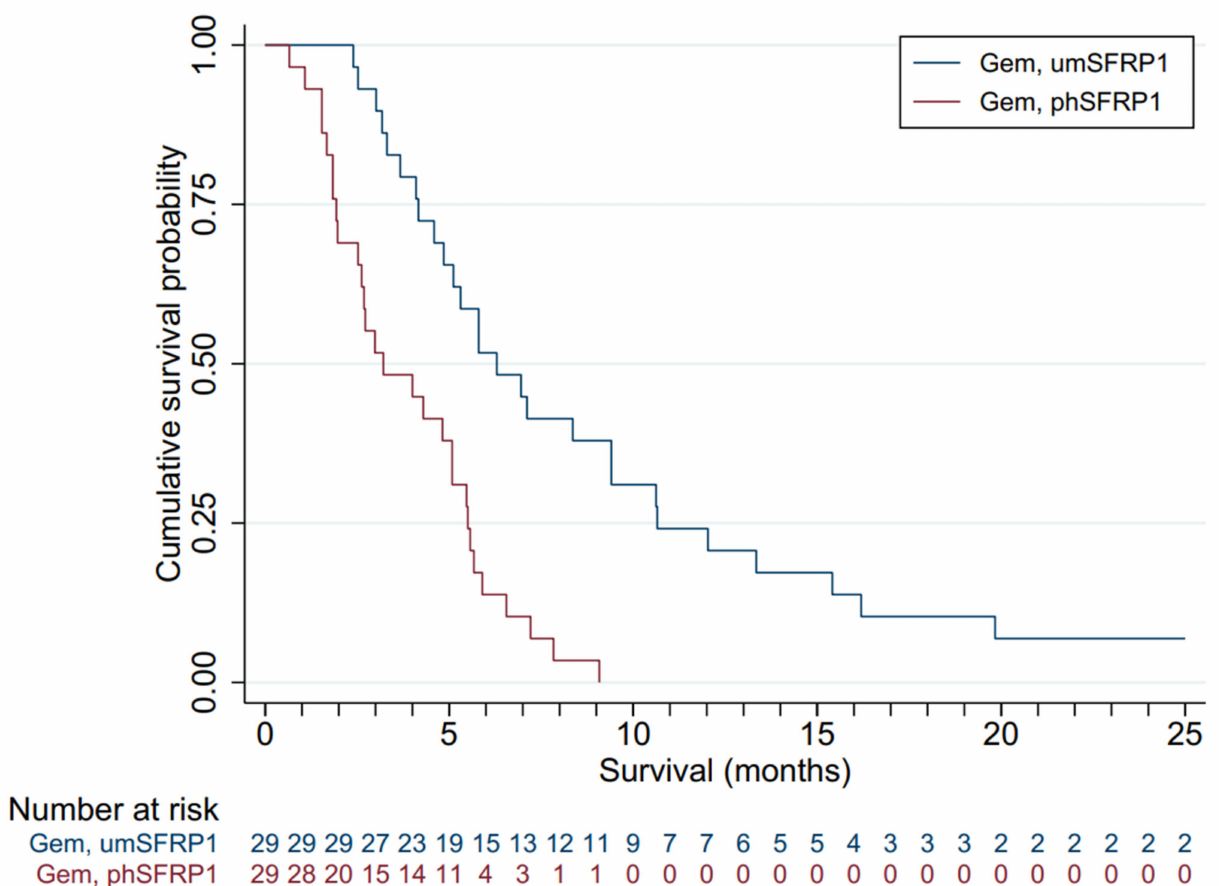
Figure 2. Kaplan–Meier survival distributions for patients included in the validation cohort, grouped by SFRP1 promoter hypermethylation status and treatment. Gem, gemcitabine chemotherapy; BSC, best supportive care; phSFRP1, patients with SFRP1 promoter hypermethylation; umSFRP1, patients without SFRP1 promoter hypermethylation. Risk table shows number of patients at risk in 1-month intervals.